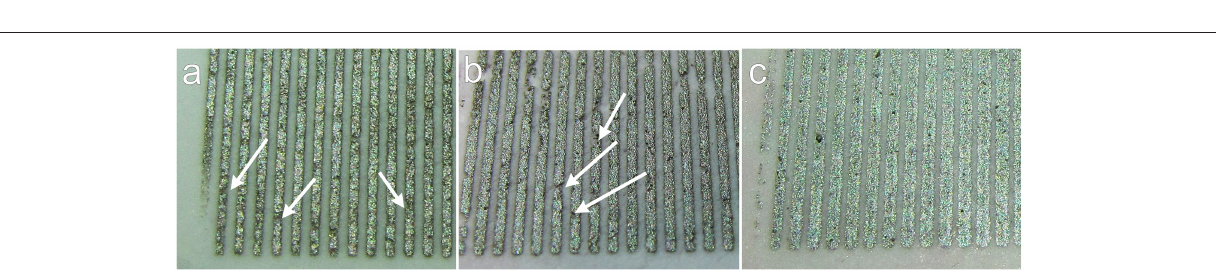
FIGURE 4 | (a–c) Printed 500 µ m wide test lines. (a) Sample with untreated surface, (b) sample with LMO coating, (c) sample with CNF coating. Damage (white arrows) on lines was observed in untreated and LMO coated samples.